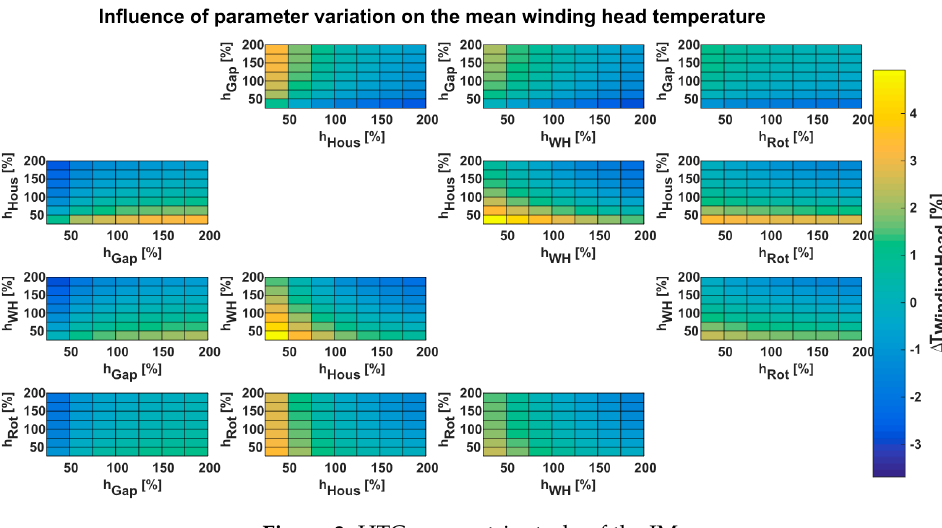
Figure 3. HTC parametric study of the IM.